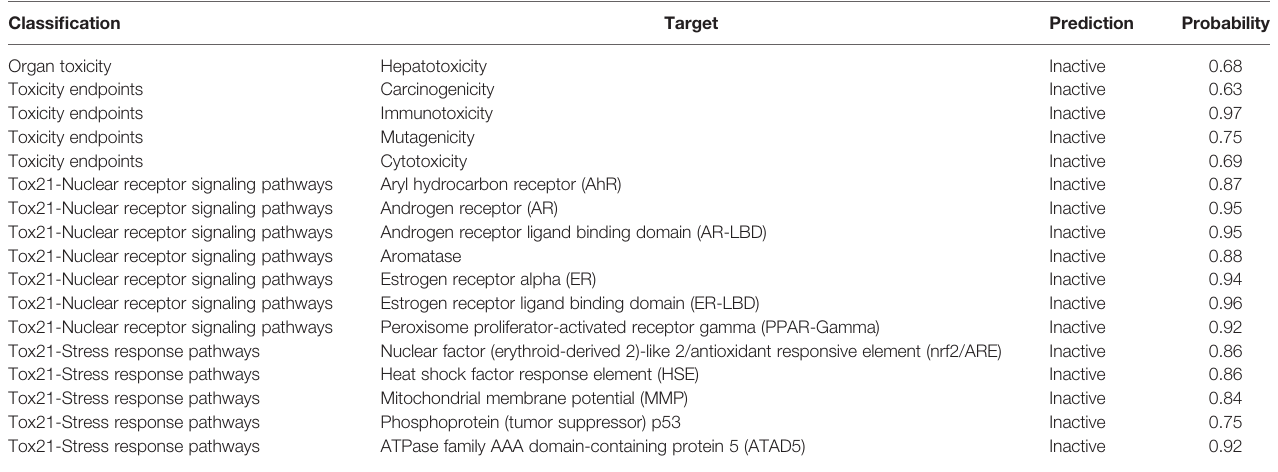
TABLE 5 | Different toxicity pro fi le of QSSM 1112 predicted through ProTox-II server. Classi fi